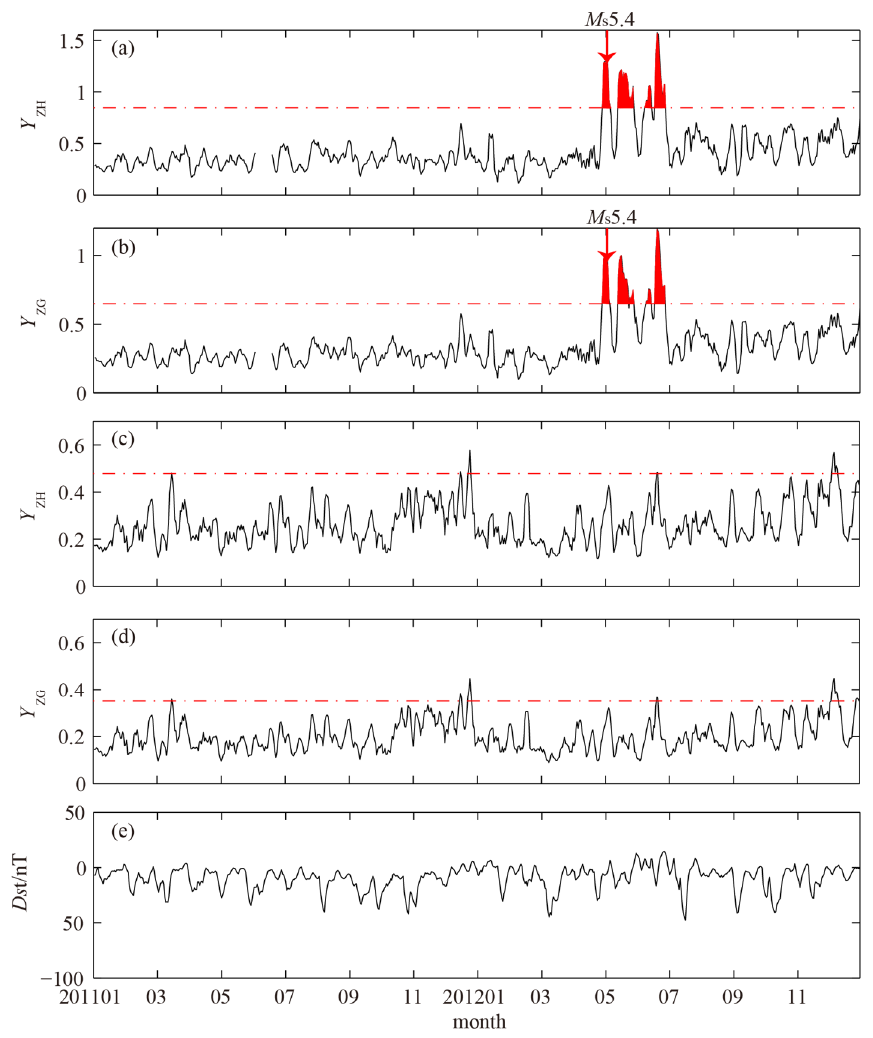
Figure 2. Polarization ratios of Y ZH at ( a ) JYG, ( c ) CNH observatories and Y ZG at ( b ) JYG, ( d ) CNH stations about 0.04 Hz from 2011 to 2012 and ( e ) Dst index.